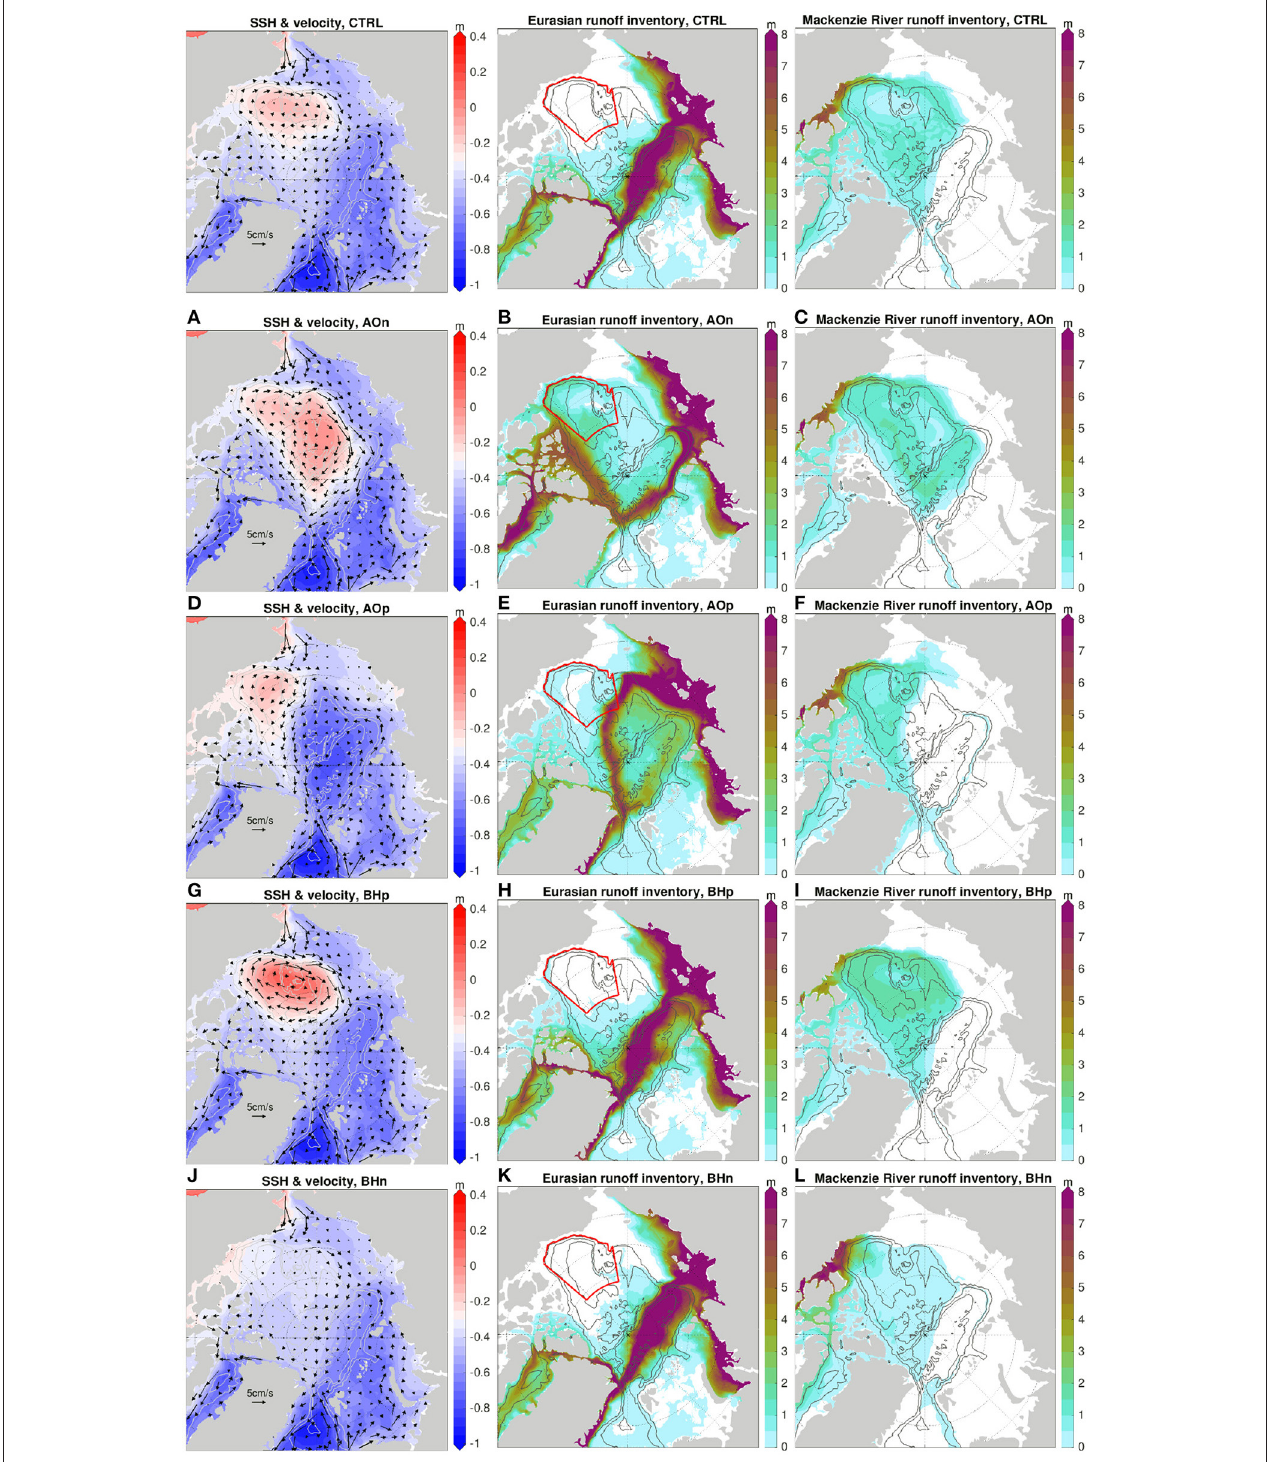
FIGURE 8 | Left: Sea surface height (SSH) and upper 150 m mean velocity in the last model year. Middle column: The inventory of Eurasian runoff (in m) in the last model year. Right: The inventory of Mackenzie River runoff in the last model year. (A–C) : the case with negative Arctic Oscillation (AO) forcing. (D–F) : the case with positive AO forcing. (G–I) : the case with positive Beaufort High (BH) forcing. (J–L) : the case with negative BH forcing. The control run results are shown in the top row of the figure for reference. The red boxes in the middle column indicate the Beaufort Gyre region. The 500, 2,000, and 3,500 m isobaths are shown with gray contour